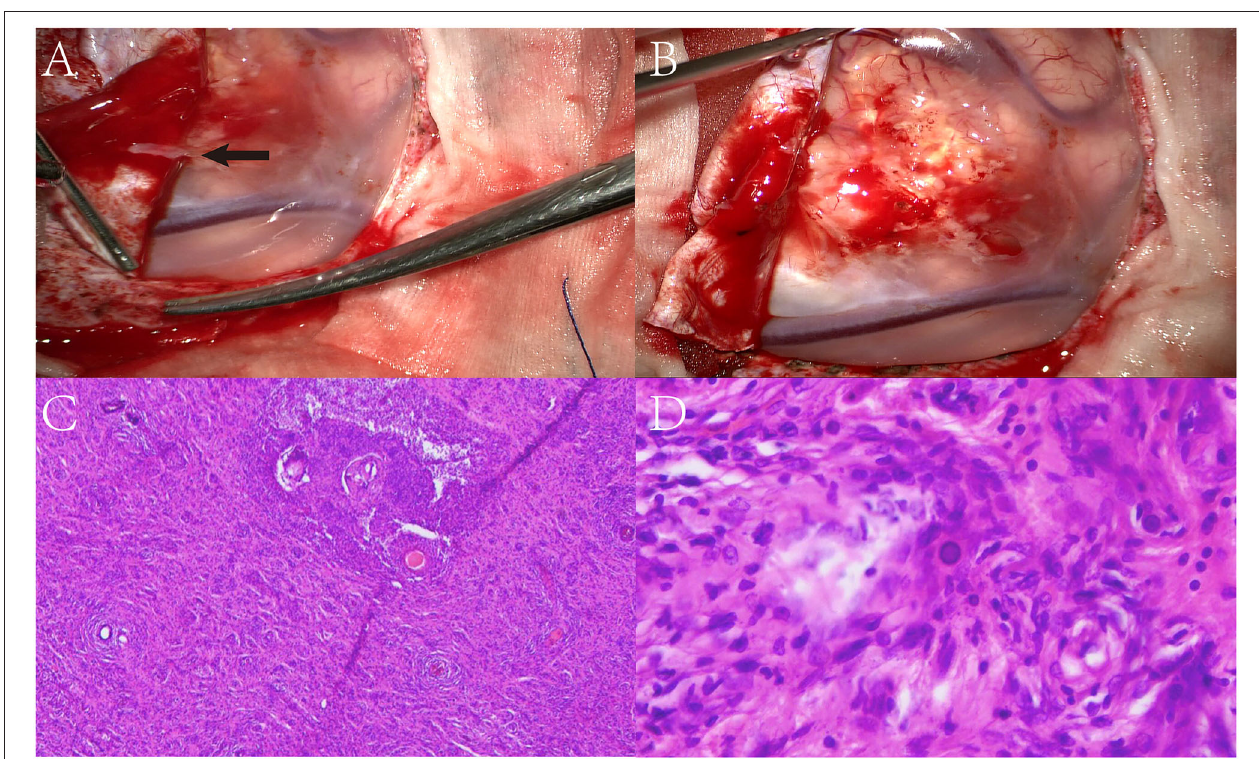
FIGURE 2 | Surgical microscopic examination showed an ill-defined mass with a grayish-yellow surface. The overlying dura was involved (black arrow) and the surrounding tissue was slightly edematous (A,B) . Biopsy showed a diffused proliferation of spindle and oval cells with some psammoma bodies present in the cortex (C,D)